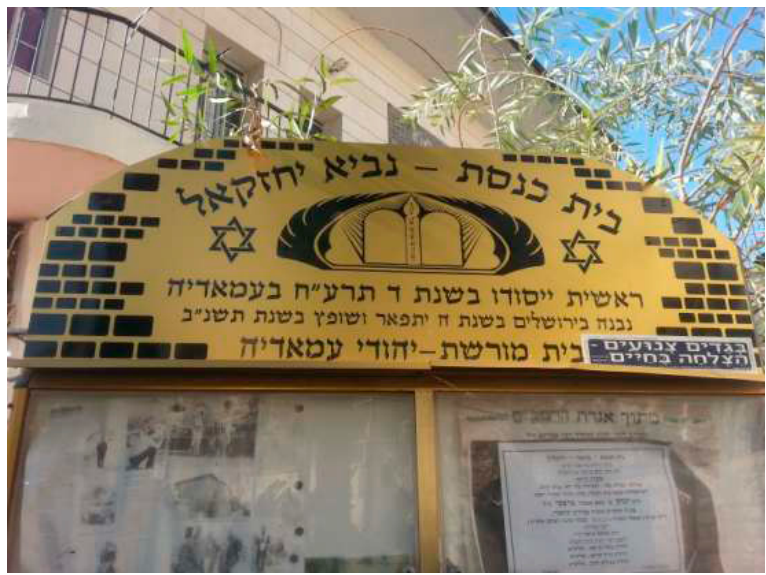
Figure 1. Panel in front of the Navi Yehezkel ( לאקזחי איבנ ) synagogue in Jerusalem (photo: Rafi Kfir, 2015).